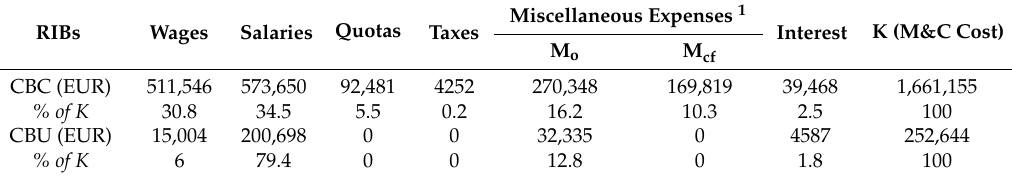
Table 6. M&C annual costs (in euros) for CBC and